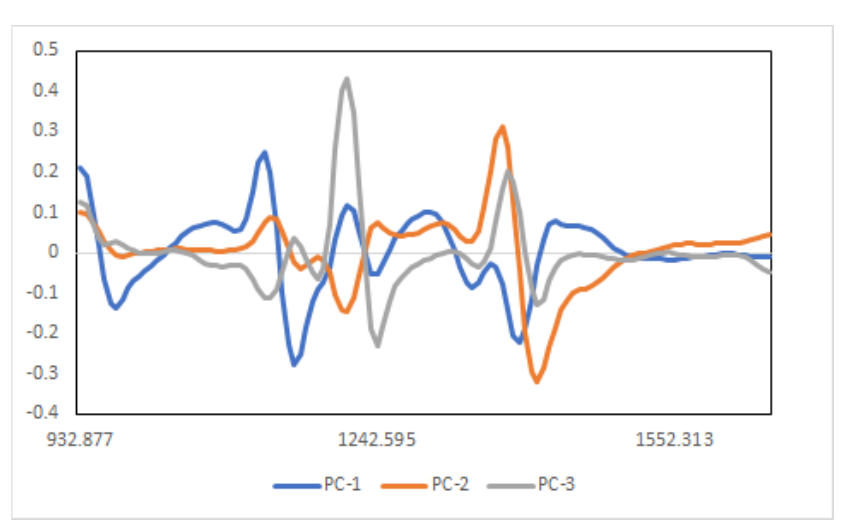
Figure 4. Principal component scores plot (panel ( A , B )) and loadings (panel ( C )) of intact goat muscles analysed using near-infrared reflectance spectroscopy.